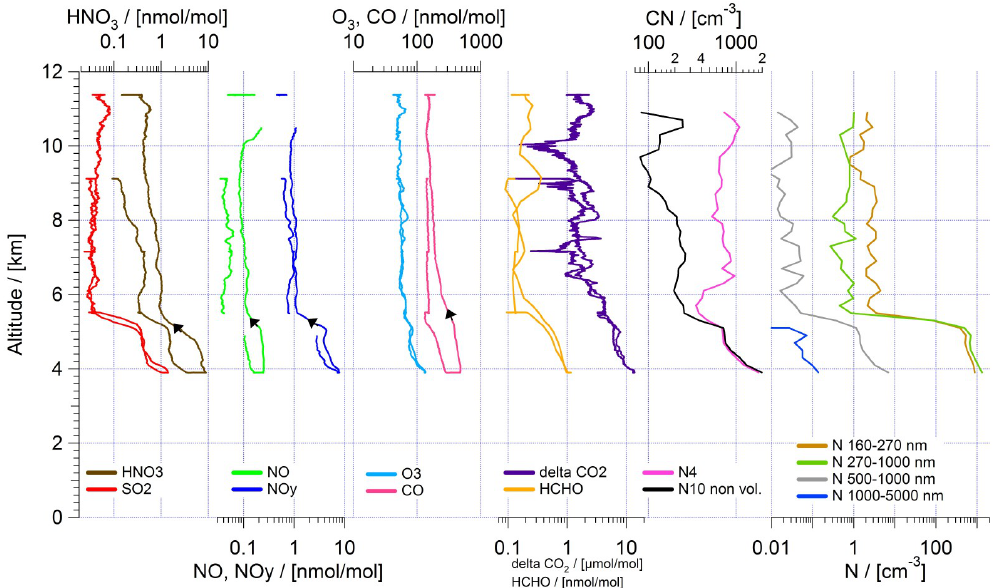
Fig. 6. Altitude profiles of SO 2 , HNO 3 , NO, NO y , O 3 , CO, CO 2 , HCHO, and aerosol particle number concentrations N x where the index x denotes the size range referred to in nm ( N 4 − 1500 , N 10 − 1500 (non-volatile particles), N 160 − 270 , N 270 − 1000 , N 500 − 1000 and N 1000 − 5000 ). For HNO 3 , NO, and CO reascent data are markedly larger than descent data. For aerosol particles averaged profiles combining descend and ascend data using the median concentration of data in 100m altitude bins are presented (no significant differences between descend and ascend